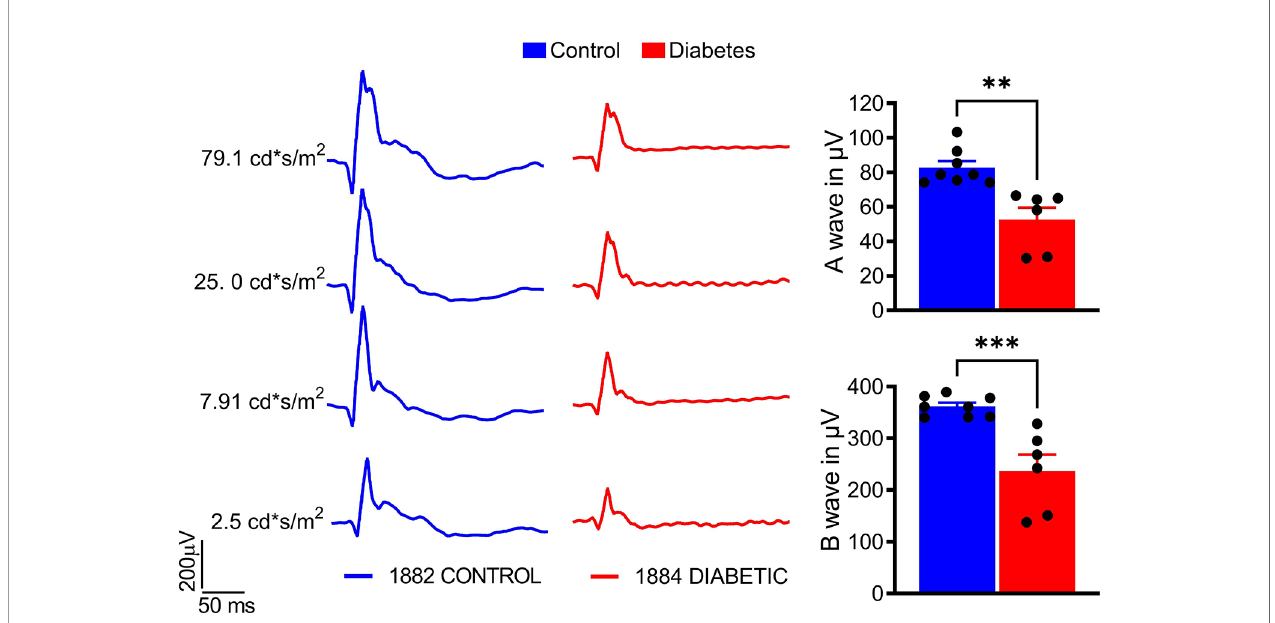
FIGURE 3 | Sustained hyperglycemia results in compromised cone photoreceptor function. The photopic ERG were recorded with the LKC setup (right). A- and B- wave photopic ERG amplitudes were diminished in the diabetic tree shrew retina (left). The calculation of the photopic ERG A- and B- wave amplitudes at 25 cd*s/m 2 is shown. **p < 0.01, ***p < 0.001, (n=